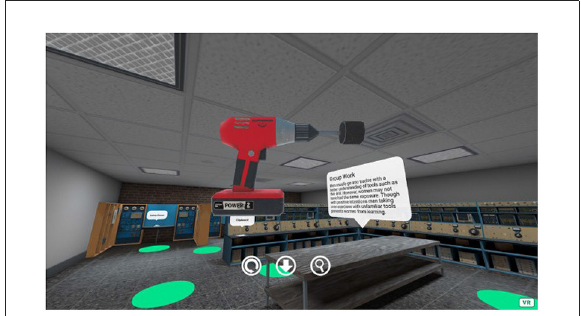
FIGURE5 The Circles framework’s “Women in Trades” Electrician’s School Lab running on Google Chrome (Desktop), from the perspective of a participant. This shows one of the three virtual artifacts—a drill—selected to learn more about microaggressions in learning spaces via audio narration, text, and object